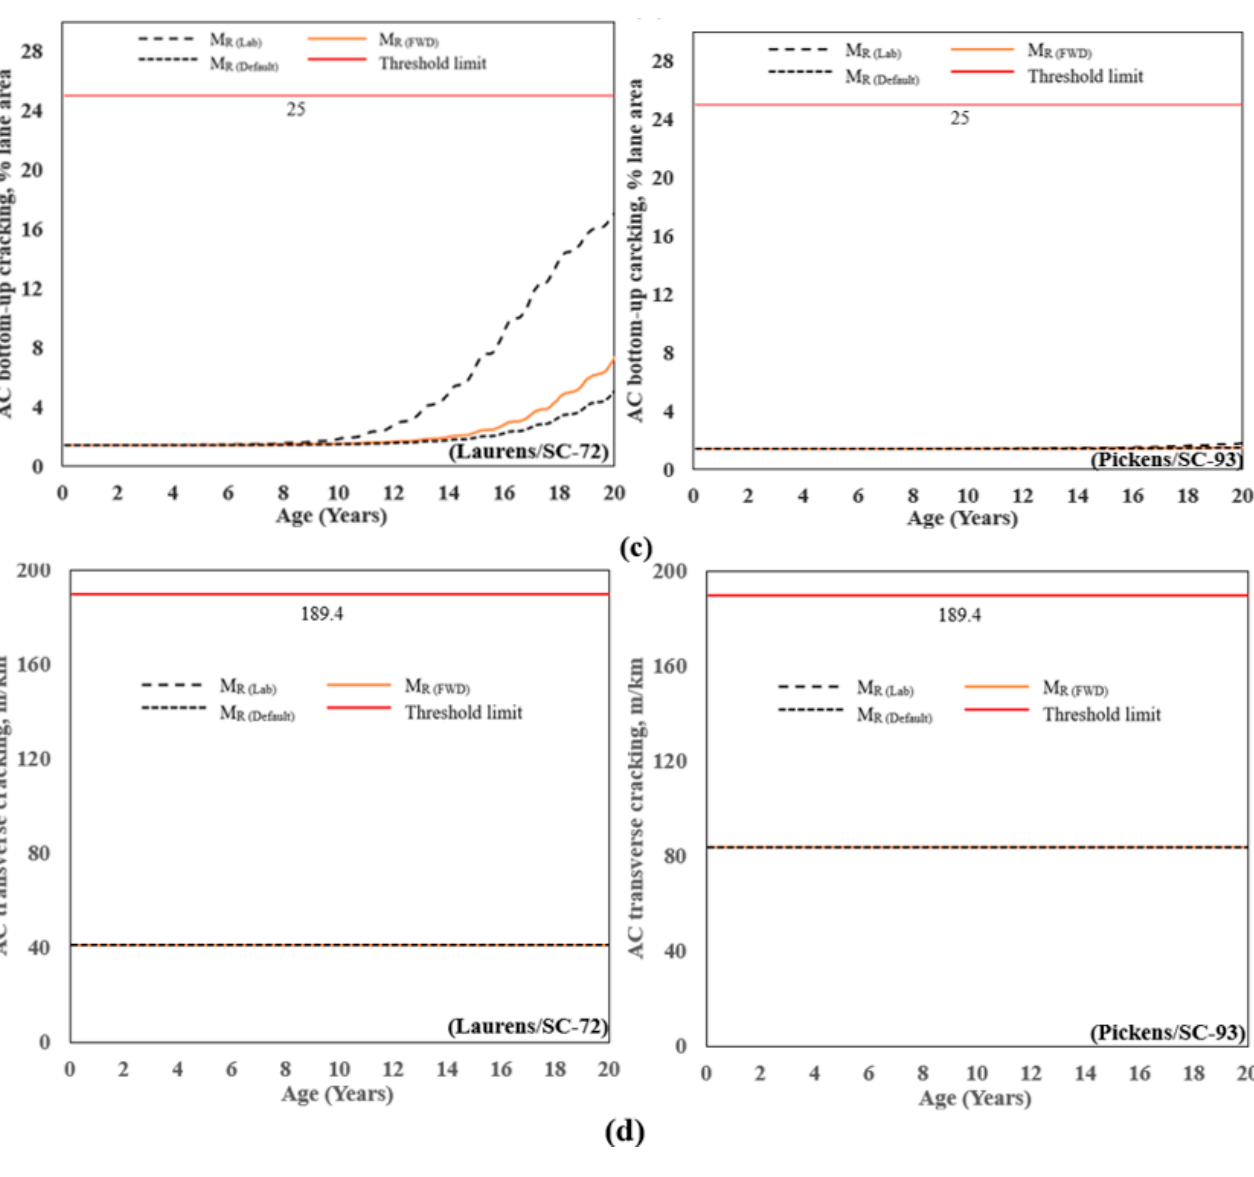
Figure 9. Predicted distress vs. time: ( a ) AC rutting, ( b ) AC top-down cracking, ( c ) AC bottom-up cracking, and ( d ) AC transverse/thermal cracking.